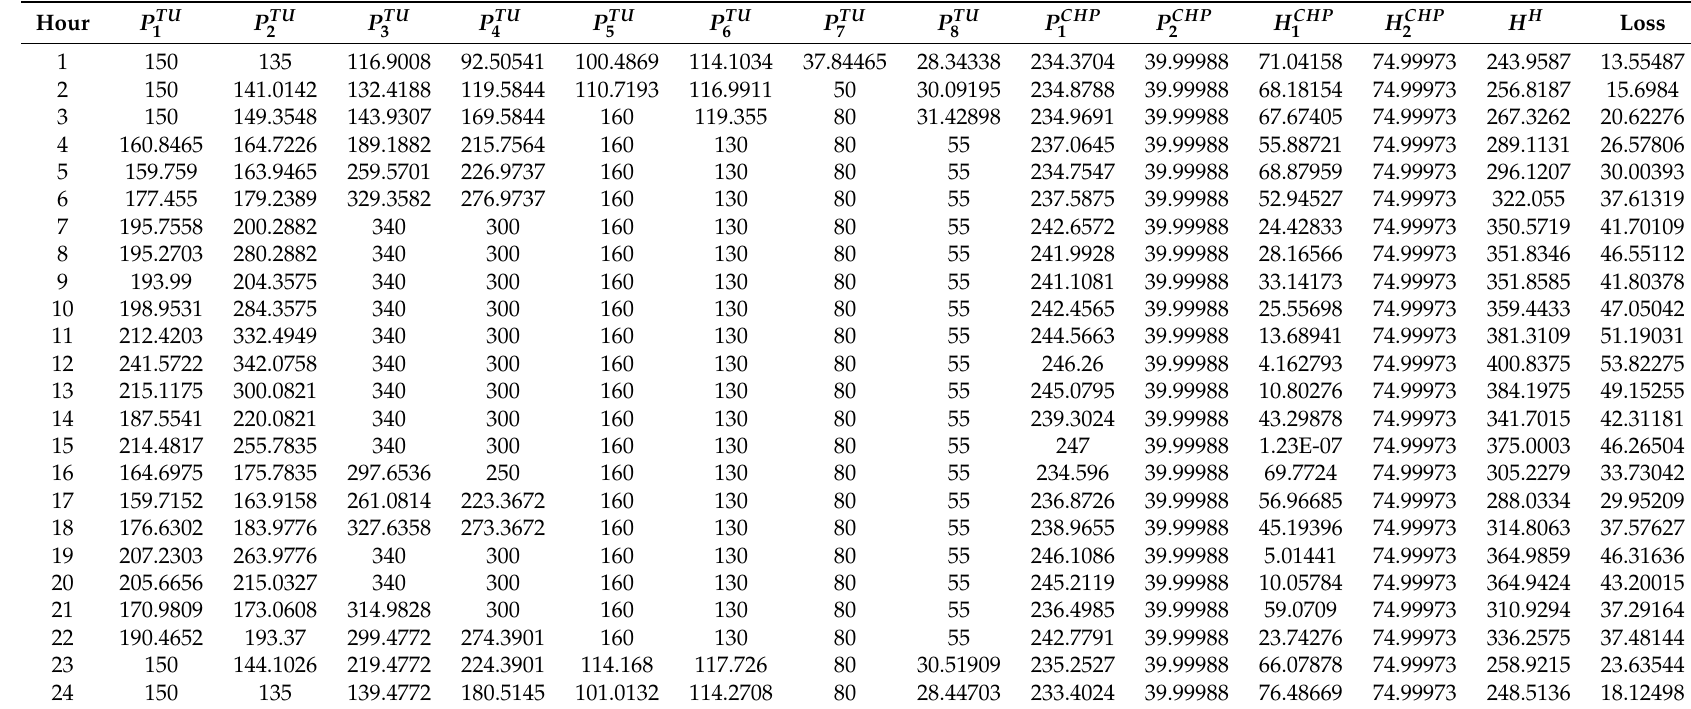
Table A3. Detailed power flow results for Case